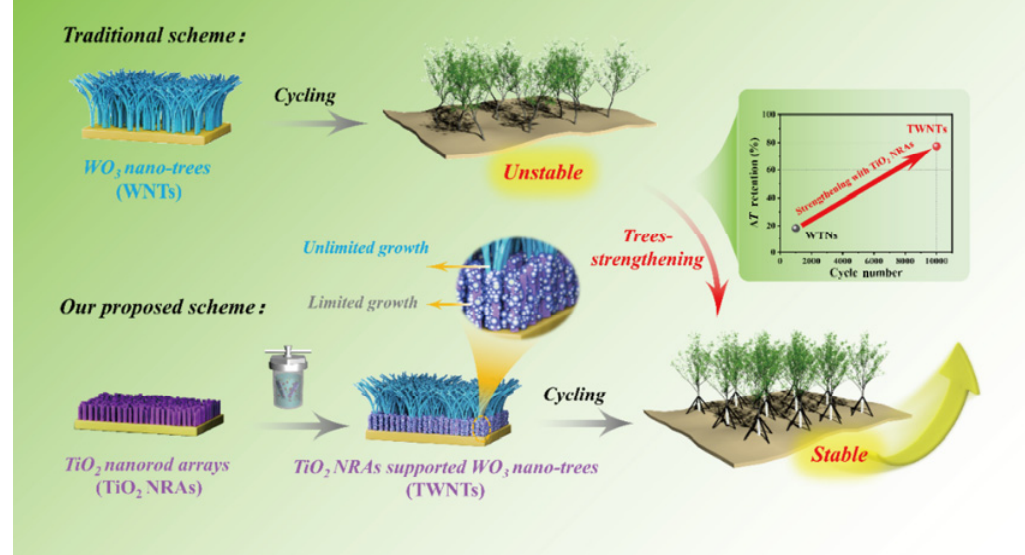
Fig. 1 Schematic illustration of the design strategies for the TiO 2 NRAs strengthened WO 3 nano-trees hierarchical heterostructure to greatly improve the structural